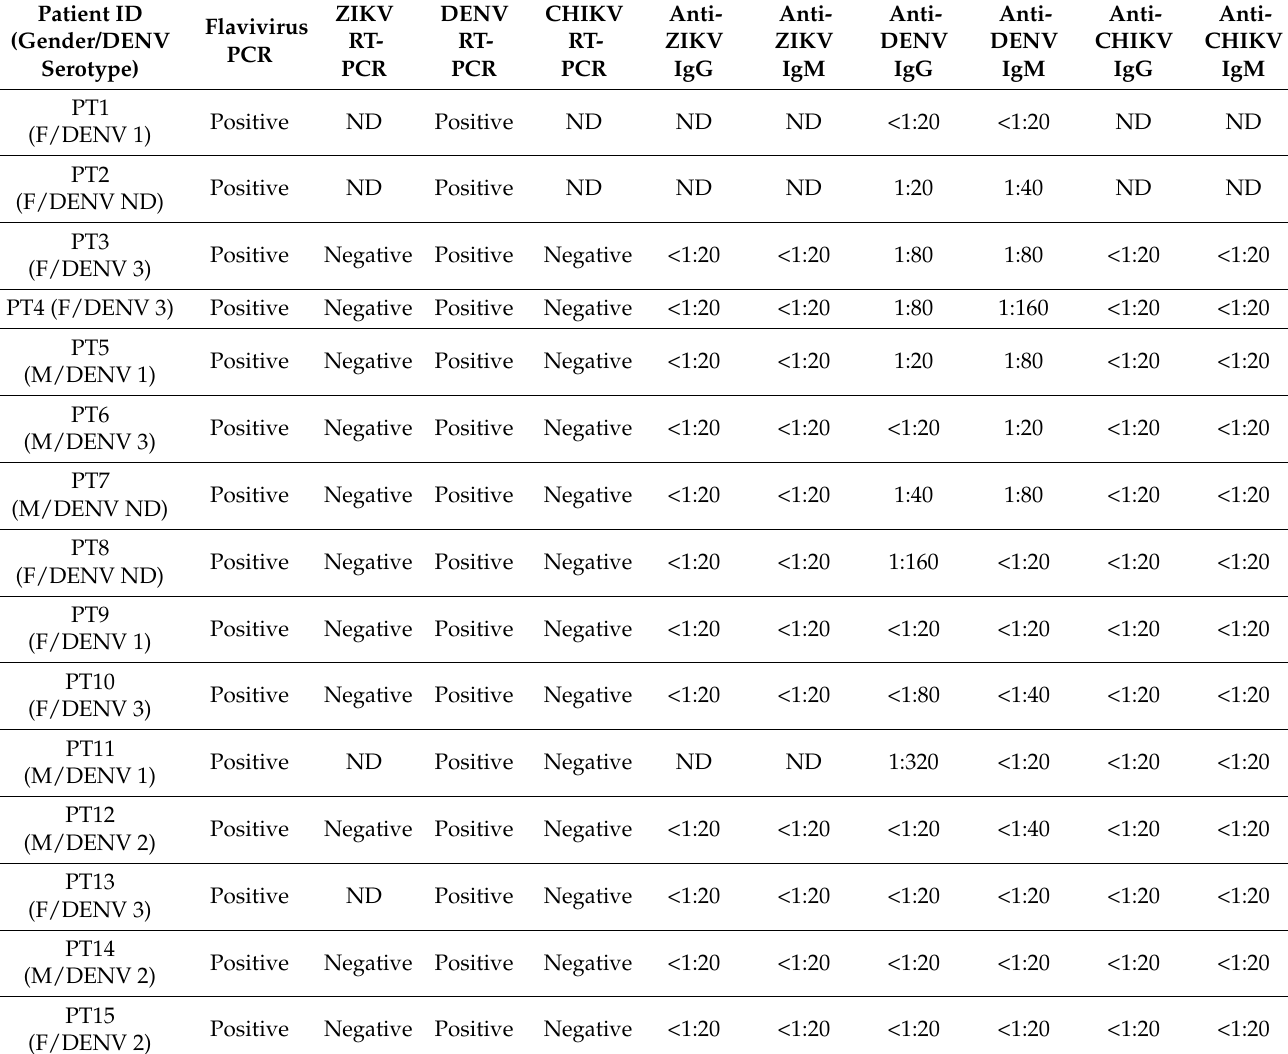
Table 2. Virological data of 15 DENV patients included in the